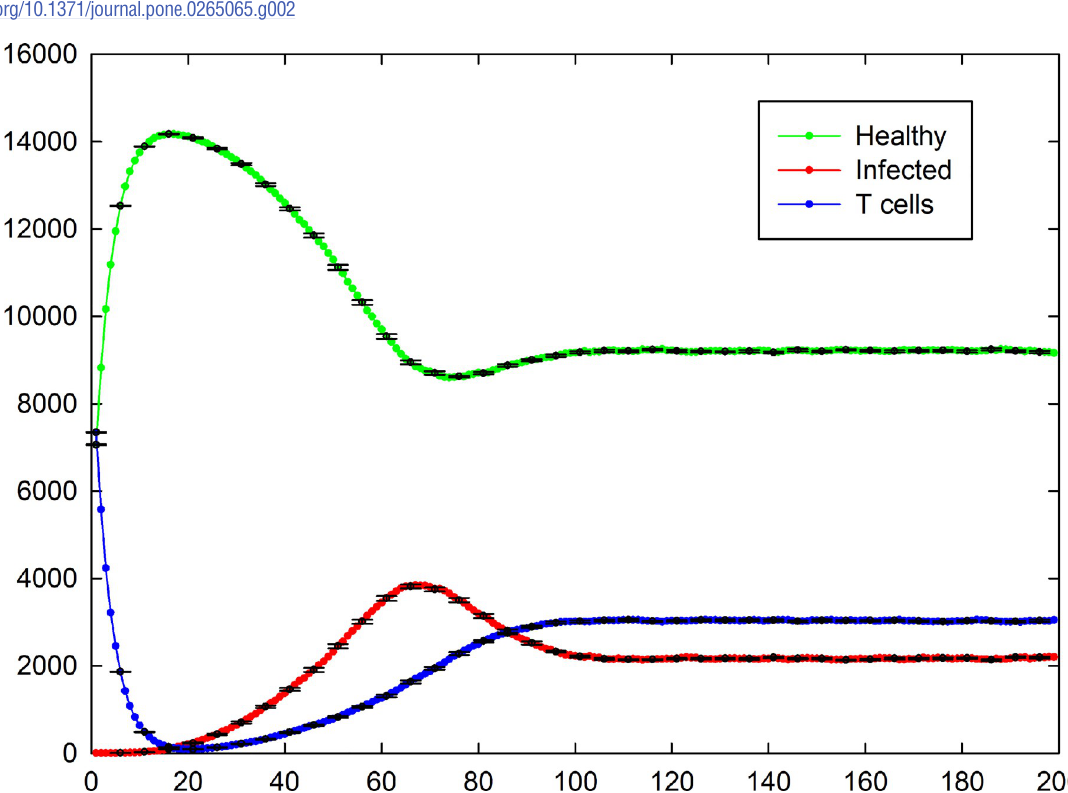
Fig 3. Total number of healthy, infected, and T cells versus time for the case of P I = 0.3, P T = 0.4, P H = 0.4, P D = 0.12. Healthy, infected, and T cells are shown in green, red, and blue, respectively. The standard errors are shown by error bars. https://doi.org/10.1371/journal.pone.0265065.g003 PLOS ONE | https://doi.org/10.1371/journal.pone.0265065 March 11,